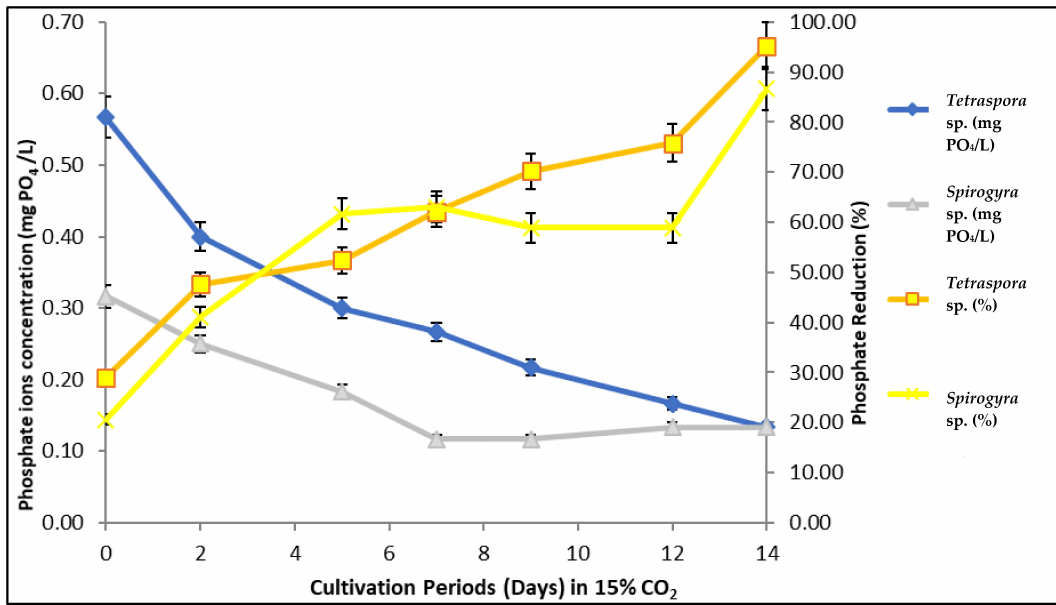
Figure 5. Phosphate ions (PO 43 − ) concentration profile during the 14 days cultivation for Tetraspora sp. and Spirogyra sp. aerated with 15% of CO 2